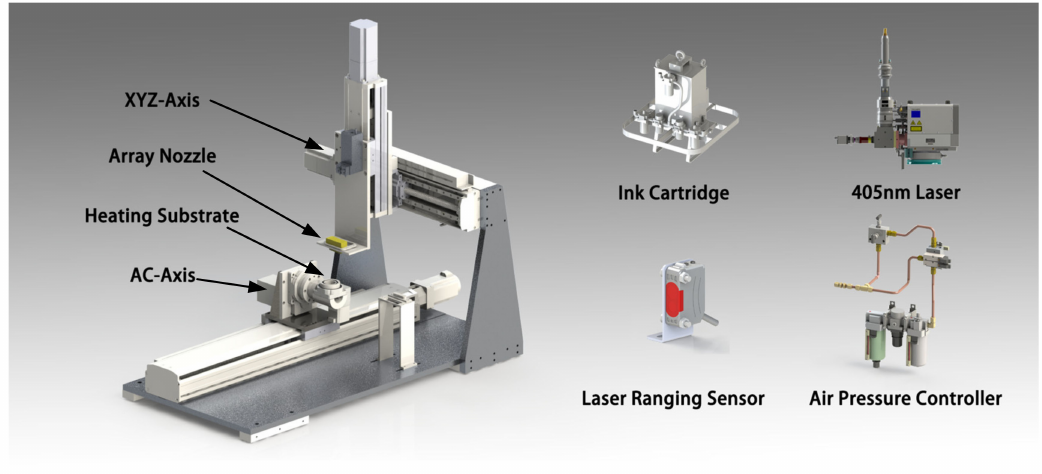
Figure 1. Print prototype mechanism